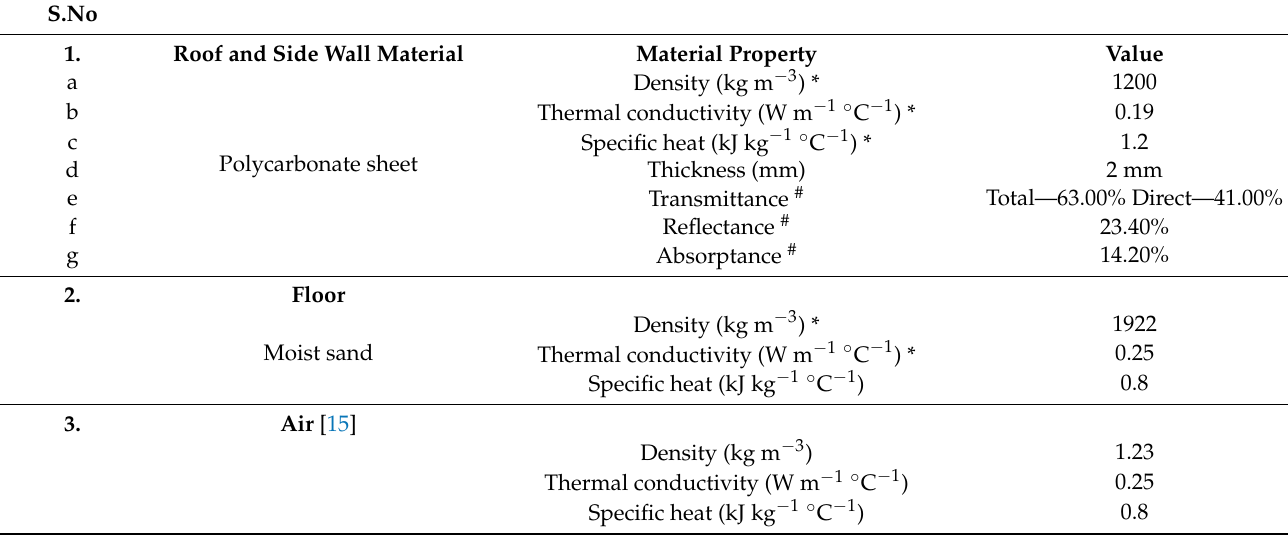
Table 1. General properties of the materials used in the greenhouse CFD simulation.